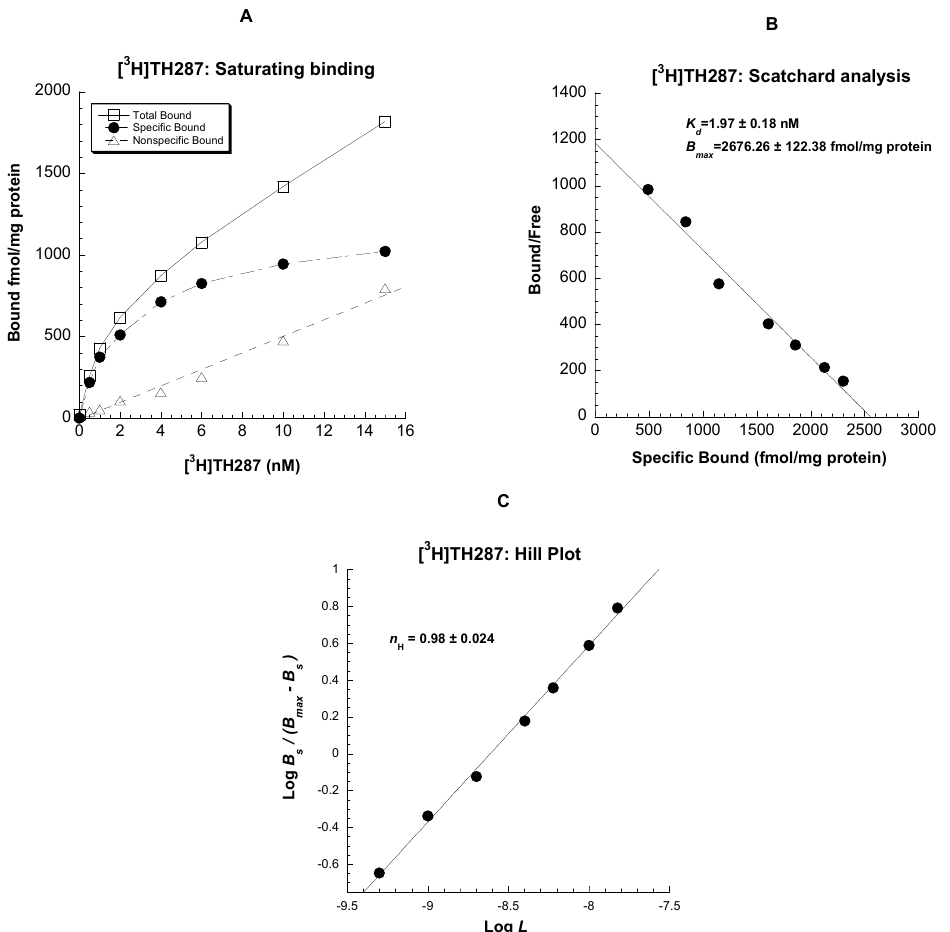
Figure 2. Scatchard analysis of [ 3 H]TH287 binding to the MTH1 in glioblastoma cells (U251MG). ( A ): Representative saturation binding experiments that show the total bound, non-specific bound, and specific bound. ( B ): Representative Scatchard plots were used to determine K d and B max values. K d = 1.97 ± 0.8 nM, B max = 2676.26 ± 122.38 fmol/mg protein. ( C ): Representative Hill plot for determining the Hill coefficient ( n H values). n H = 0.98 ± 0.024. n = 3, samples in triplicate.